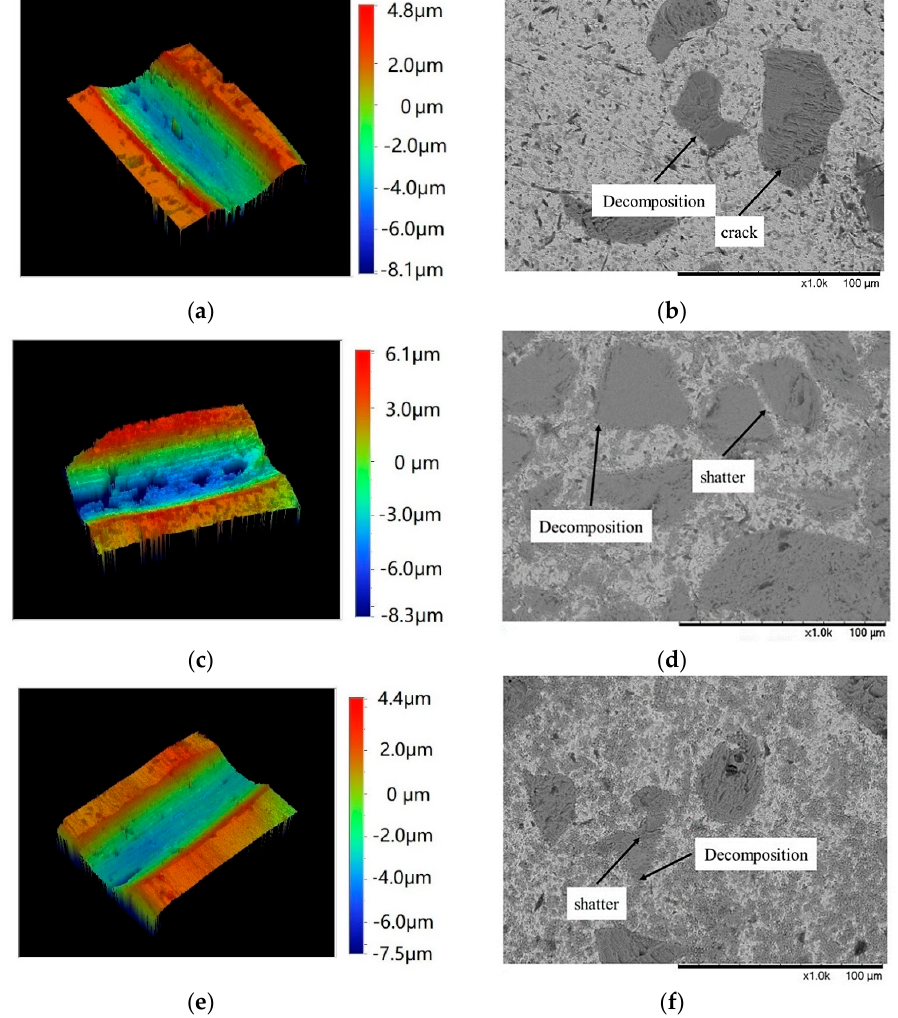
Figure 8. 3D morphology of wear and microstructure of the sample made with ( a,b ) LP 275 W, SS 7.20 mm/s, PR 20%, PF 7 rpm; ( c,d ) LP 300 W, SS 6.35 mm/s, PR 40%, PF 6 rpm, and ( e,f ) LP 325 W, SS 5.50 mm/s, PR 20%, PF 7 rpm.